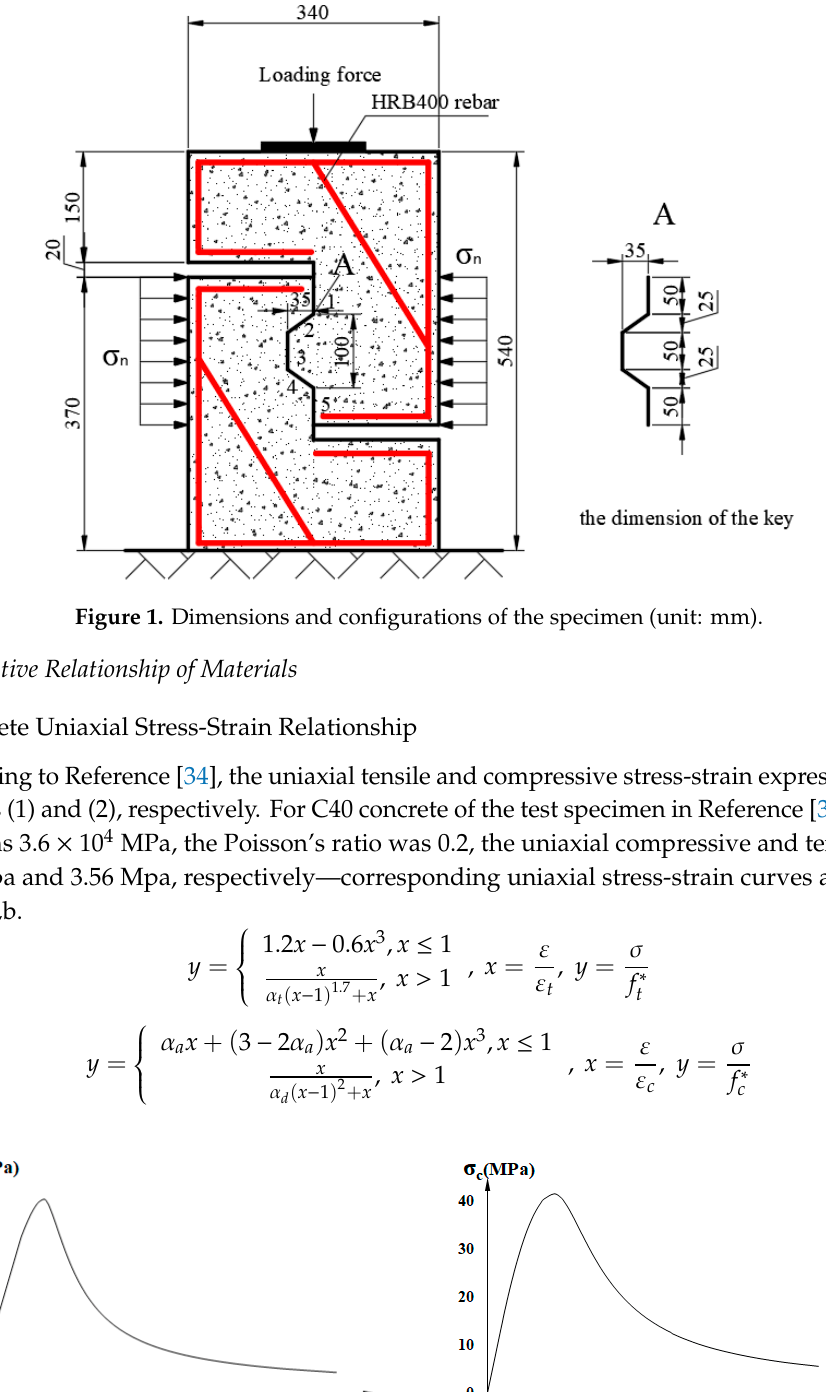
Figure 1. Dimensions and configurations of the specimen (unit: mm).